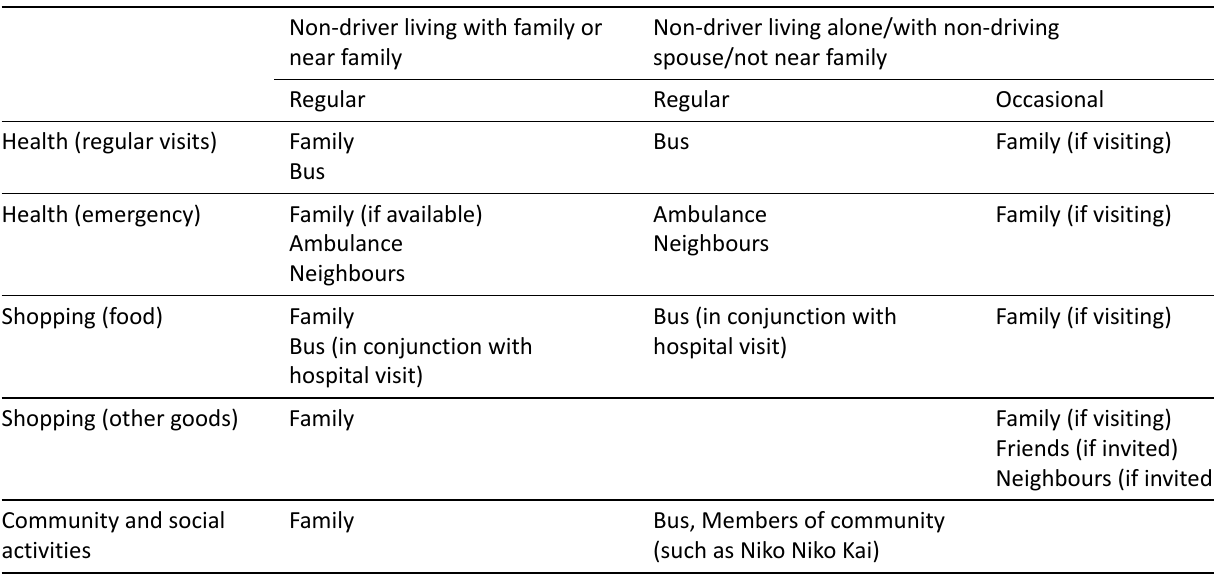
Table 3. Purpose and mode of